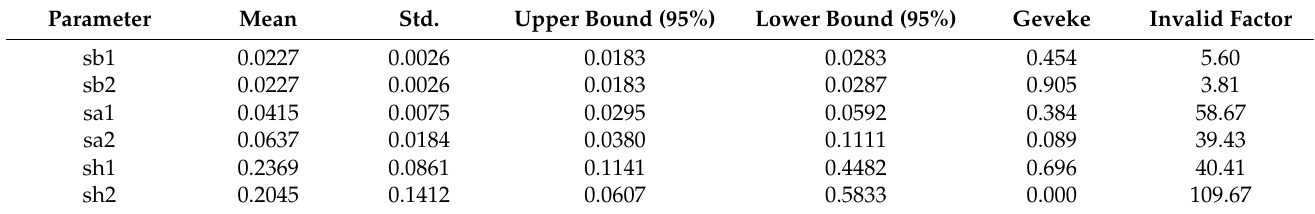
Table 8. Parameter estimation